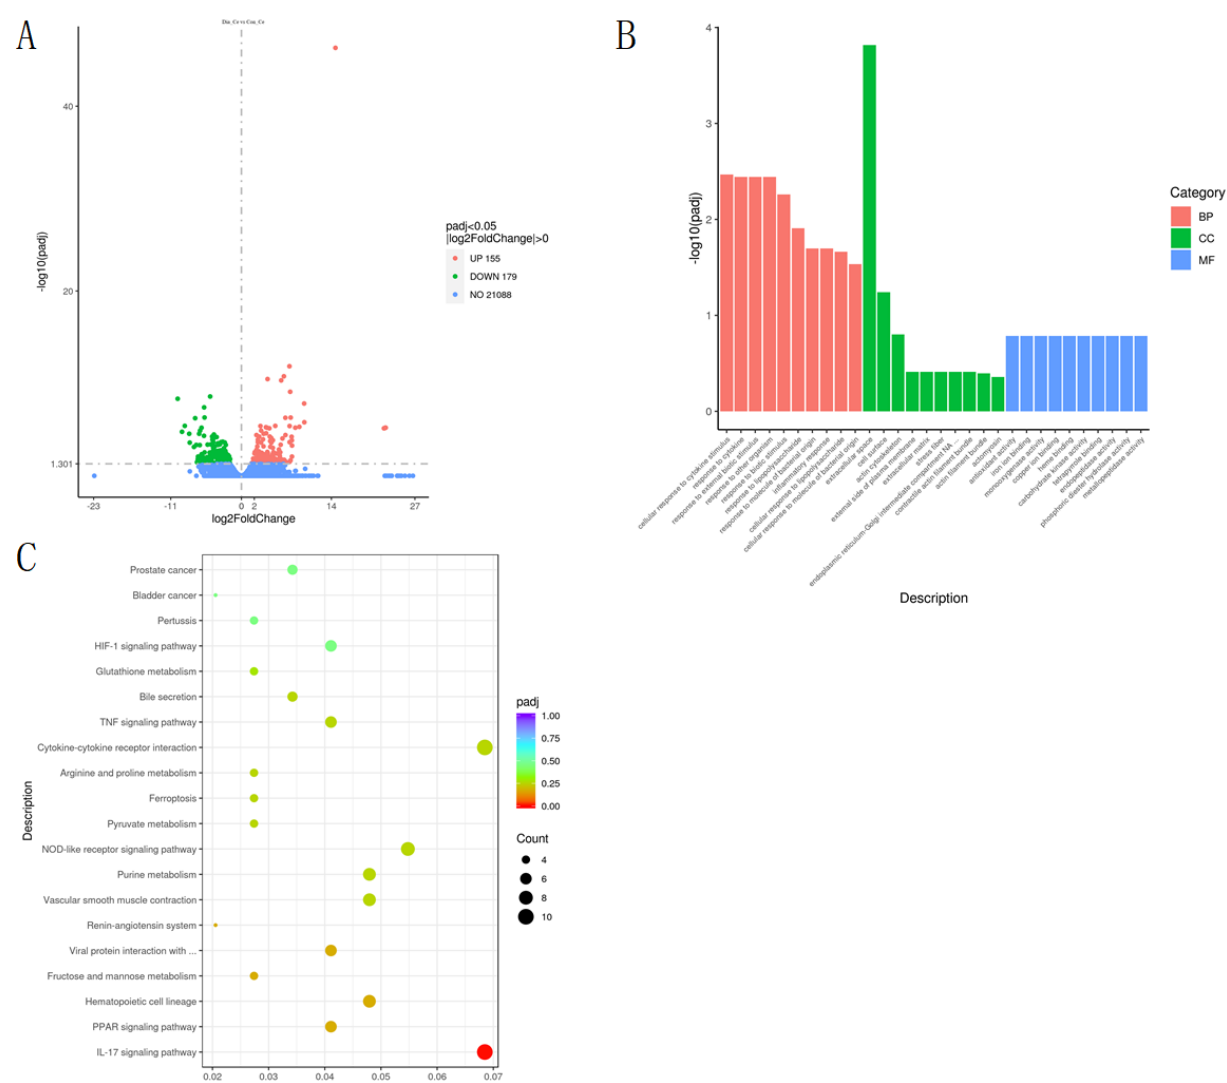
Figure 3. Differentially expressed genes in cecum of diarrhea-afflicted rabbits. ( A ) Volcano map of DEGs in cecum tissue of Con_Ce and Dia_Ce. ( B ) GO terms of Dia_Ce vs. Con_Ce. ( C ) KEGG pathways of Dia_Ce vs. Con_Ce.